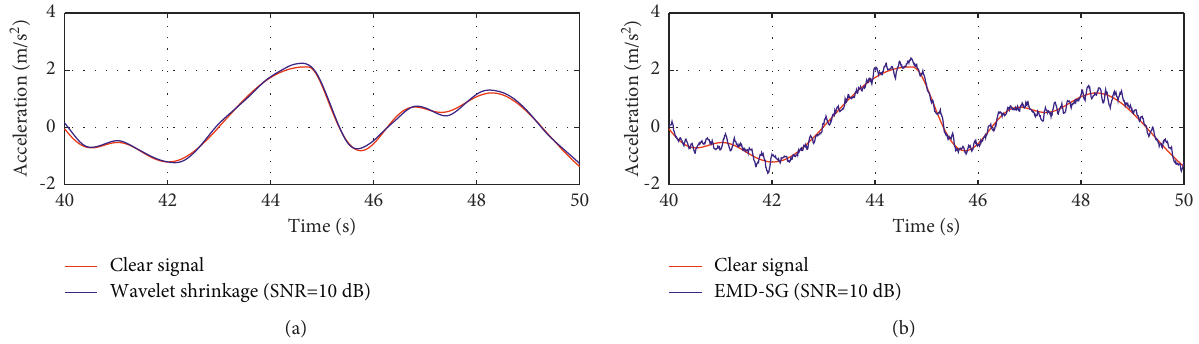
Figure 10: Noise elimination of non-linear signal using traditional methods: (a) wavelet shrinkage method; (b) EMD-SG method.